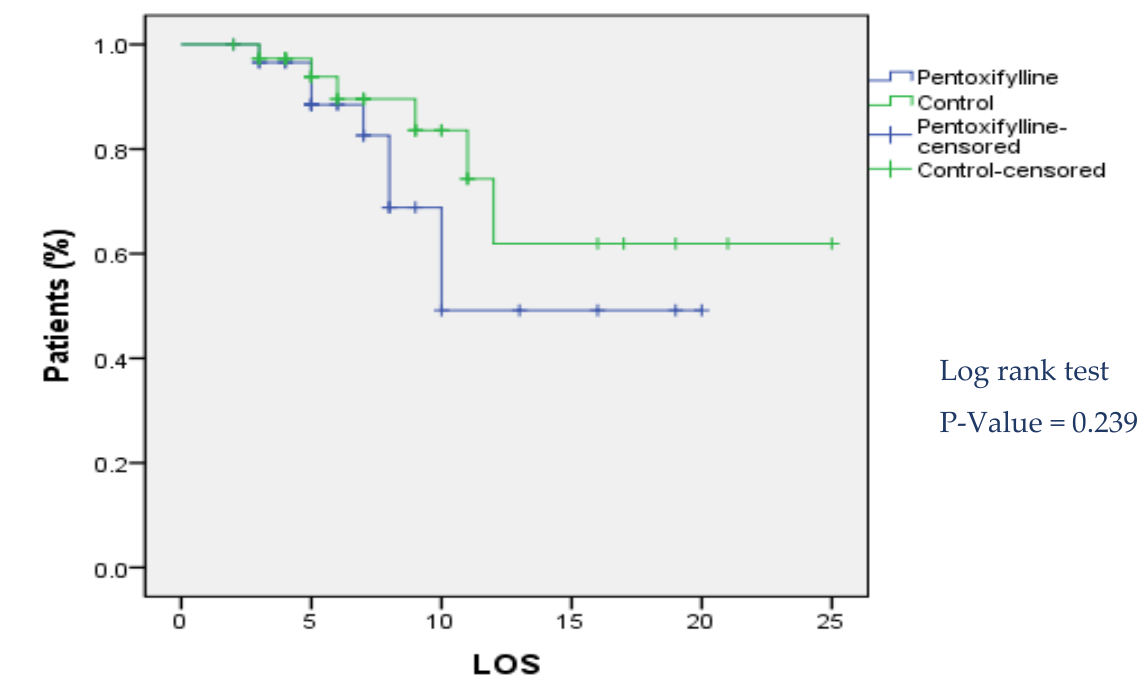
Figure 3. Kaplan – Meier curve for length of hospital stay. Figure 3. Kaplan–Meier curve for length of hospital